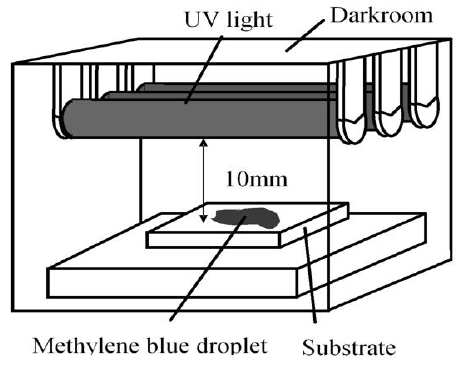
Figure 11. Schematic diagram of the equipment used in methylene ‐ blue decoloration test.